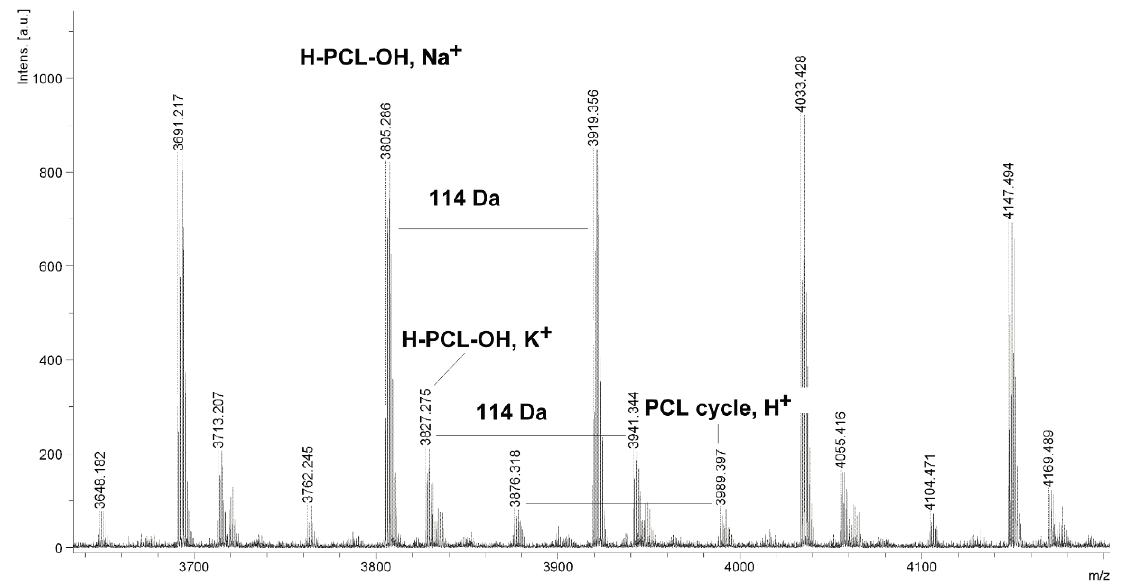
Figure 7. MALDI TOF MS spectrum of PCL obtained in the presence ZnEt 2 /PGAc catalytic system ( PCL-11